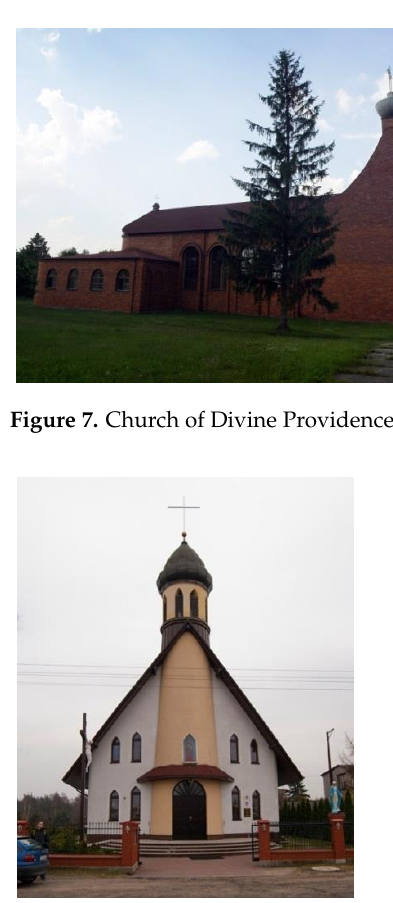
Figure 6. Church of John the Baptist in Radomsko (built in 1989–92).